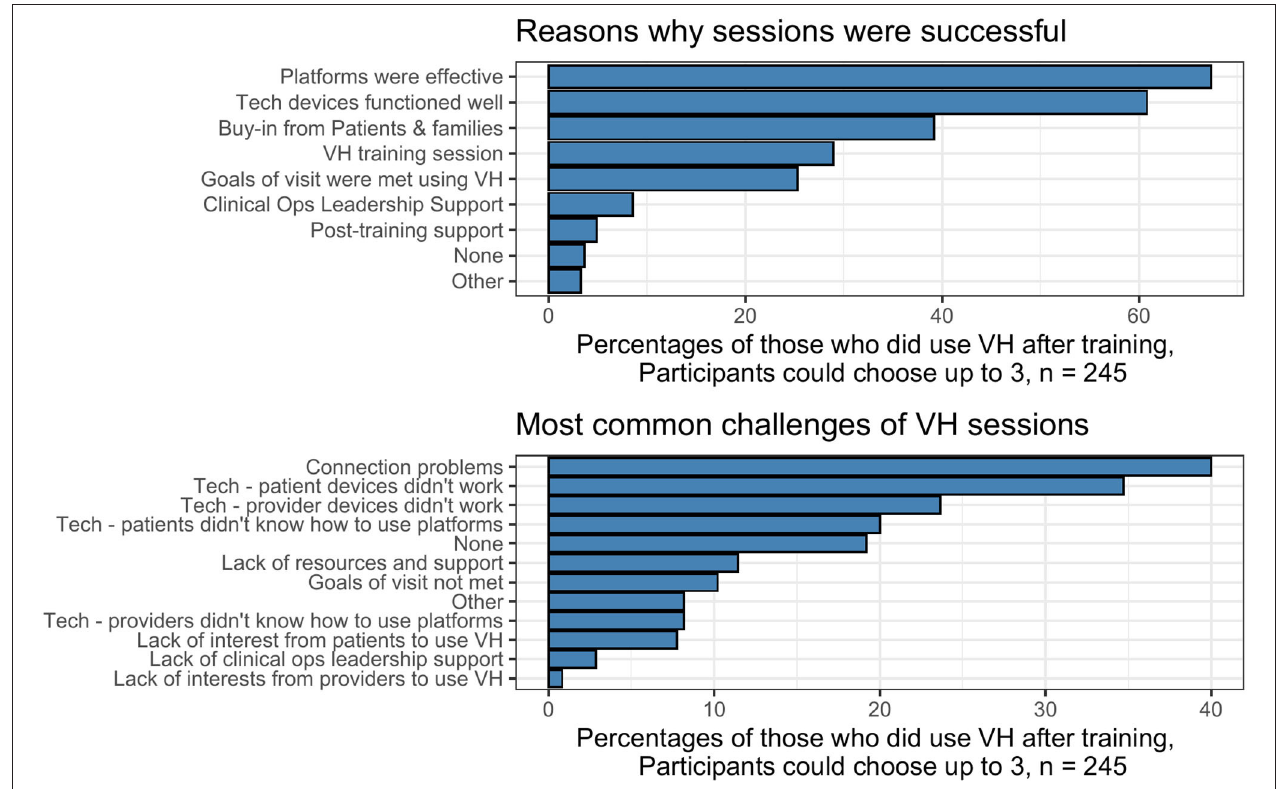
Frontiers in Pediatrics |